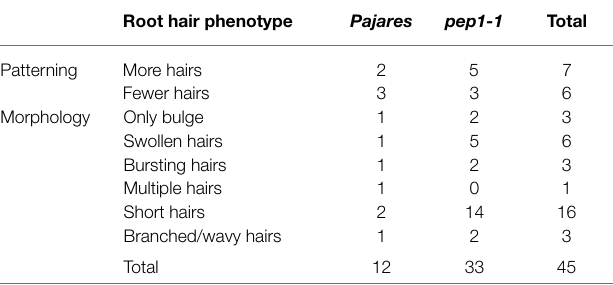
TABLE 1 | Classes of root hair mutants in A. alpina.